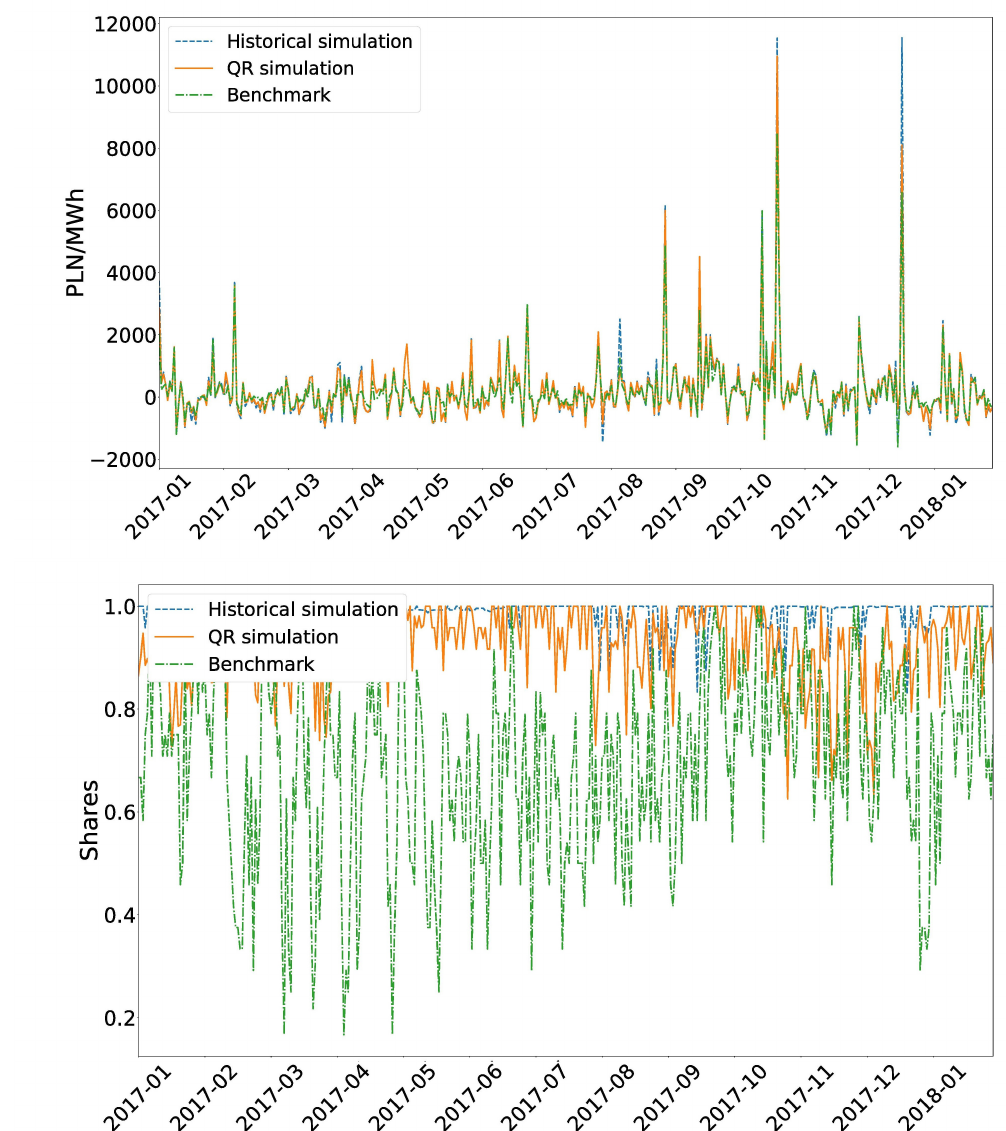
Figure 2. Daily profits from the benchmark strategy and the strategy based on maximization of the 95% quantile of the future portfolios value ( top pane l). Daily shares of sale on the balancing market associated with the benchmark strategy and the proposed 95% quantiles maximization strategy ( bottom panel ). The results of the historical method are plotted for the model structure yielding the highest profit, i.e., with X 2 , X 3 , and L = [ 2,7 ]